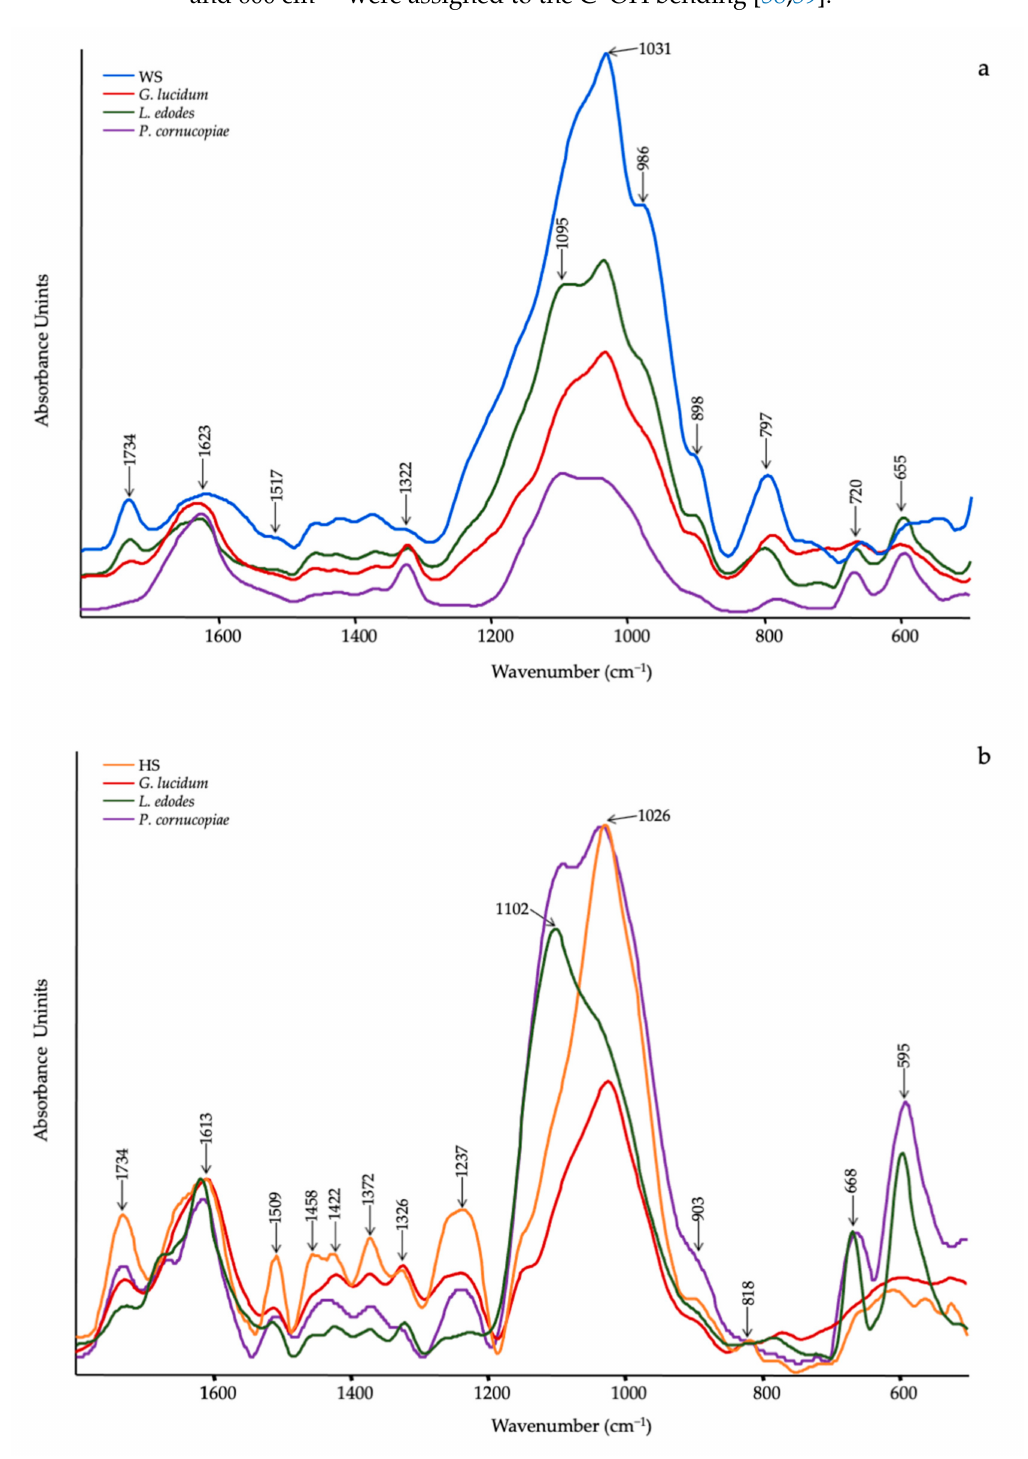
Figure 2. ATR-FTIR spectra of ( a ) WS (blue line) and ( b ) HS (orange line) after 30 d of mycelial growth of G. lucidum (red line), L. edodes (green line) and Pleurotus cornucopiae (purple